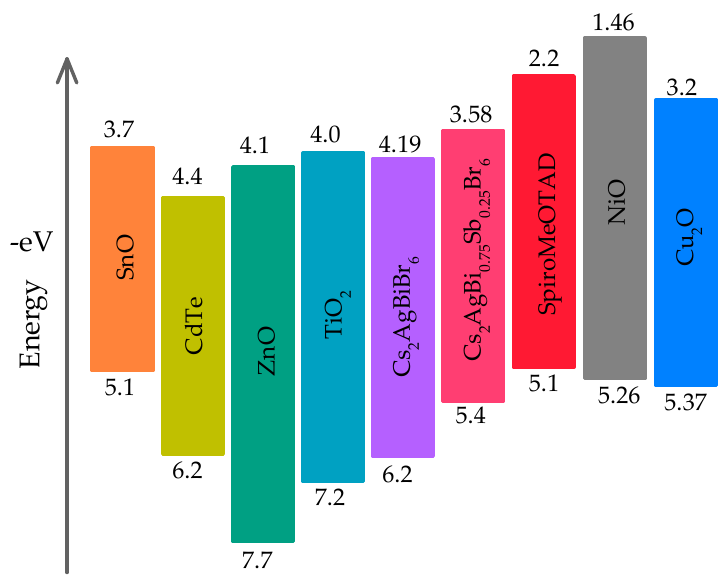
Figure 9. Schematic of the energy levels of two halide double perovskites with various ETMs and HTMs [51,55–57].